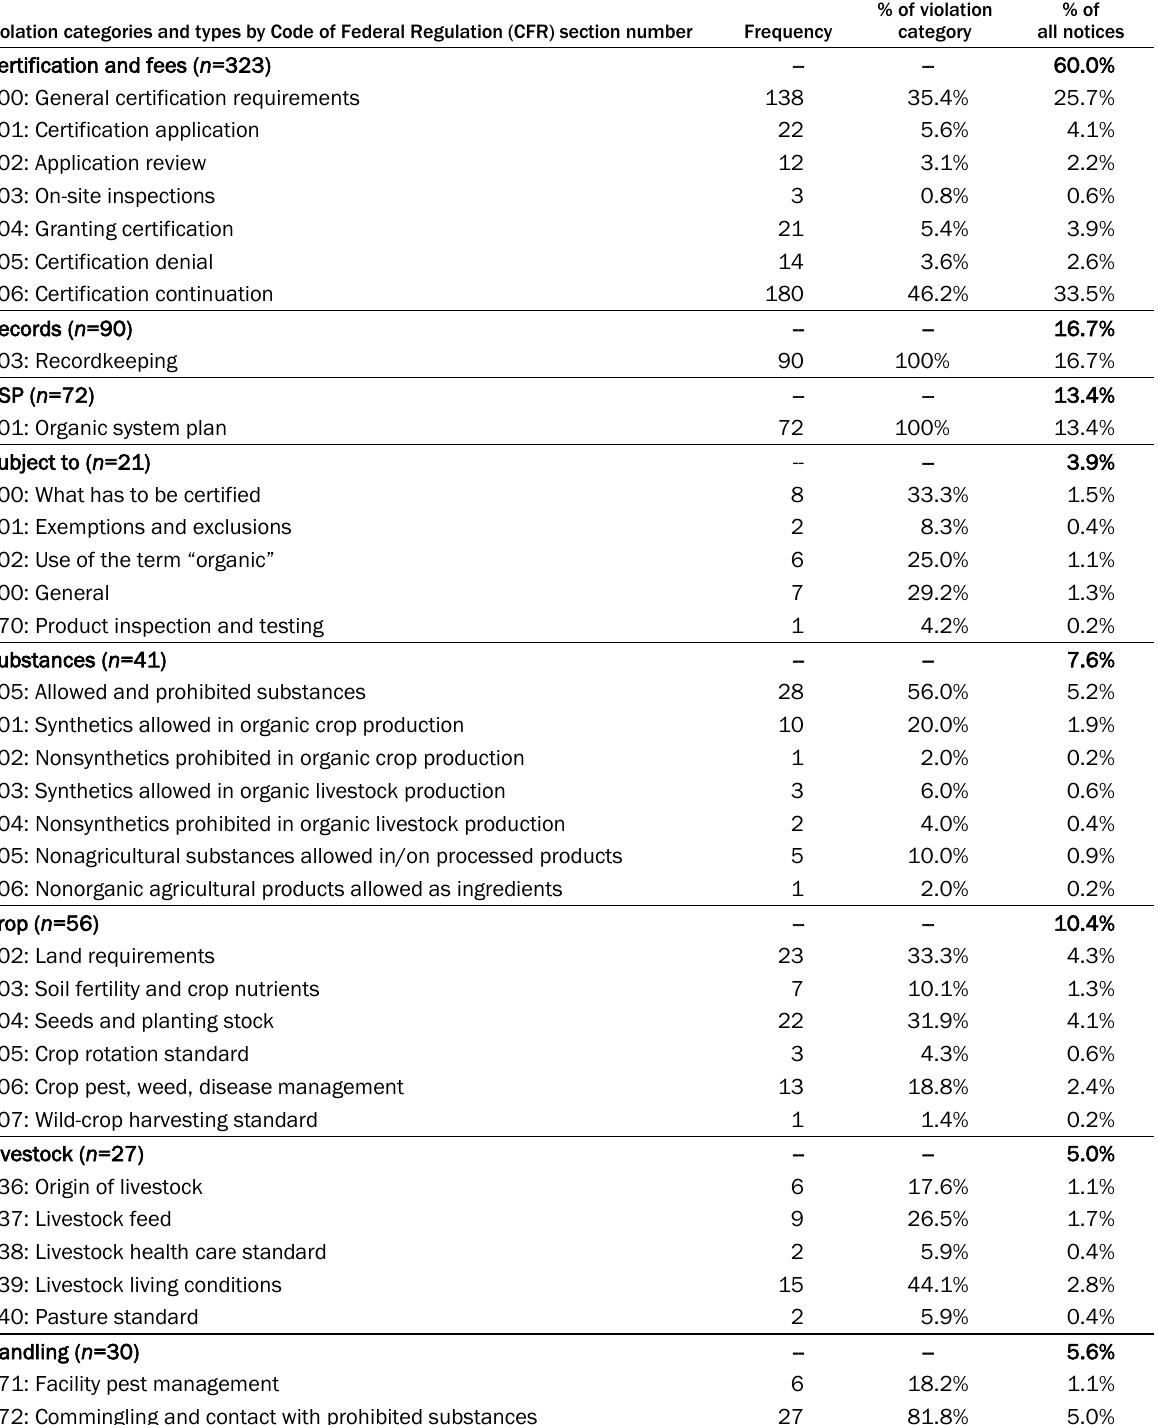
Table 2. Detailed Violation-Type Coding